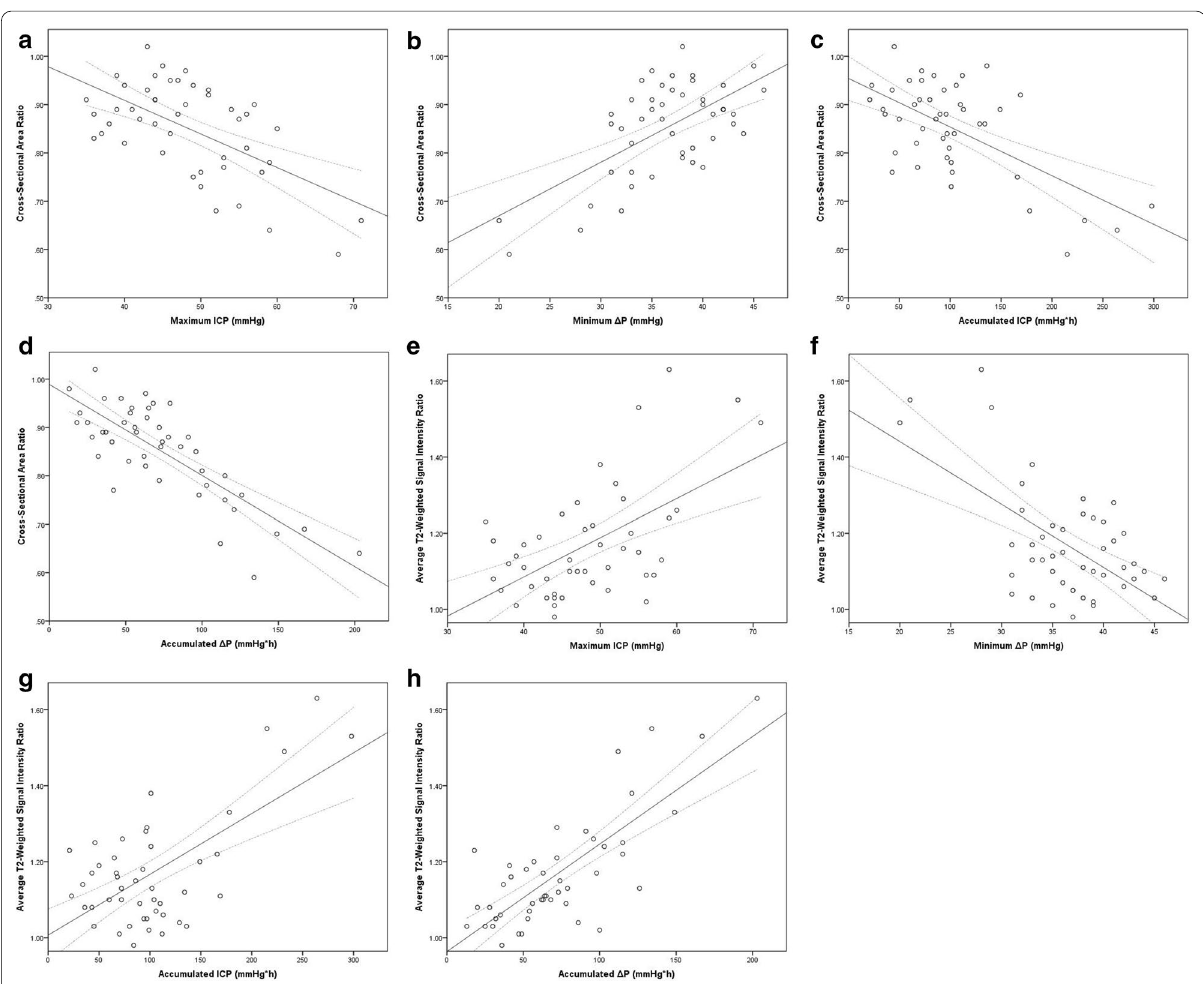
Fig. 5 a – d Simple linear regression analyses of CSAR with the maximum ICP, minimum Δ P , accumulated ICP, and accumulated Δ P . e – h